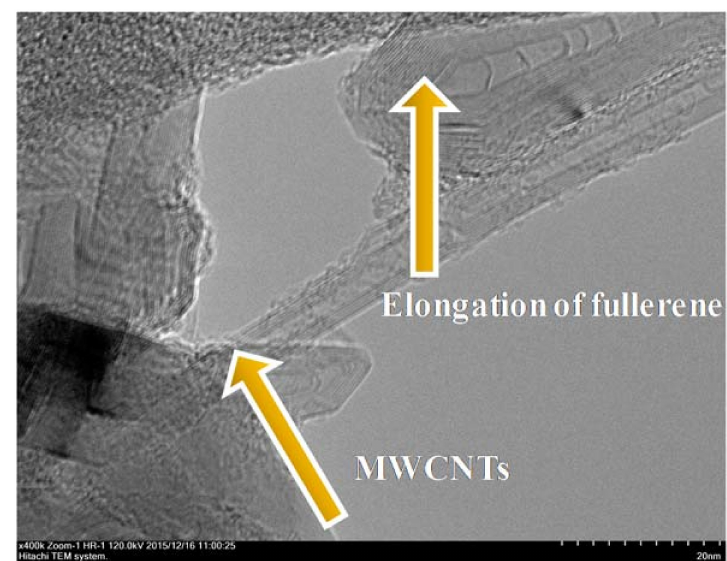
Figure 3. Elongation of the fullerene to form the MWCNT structure.